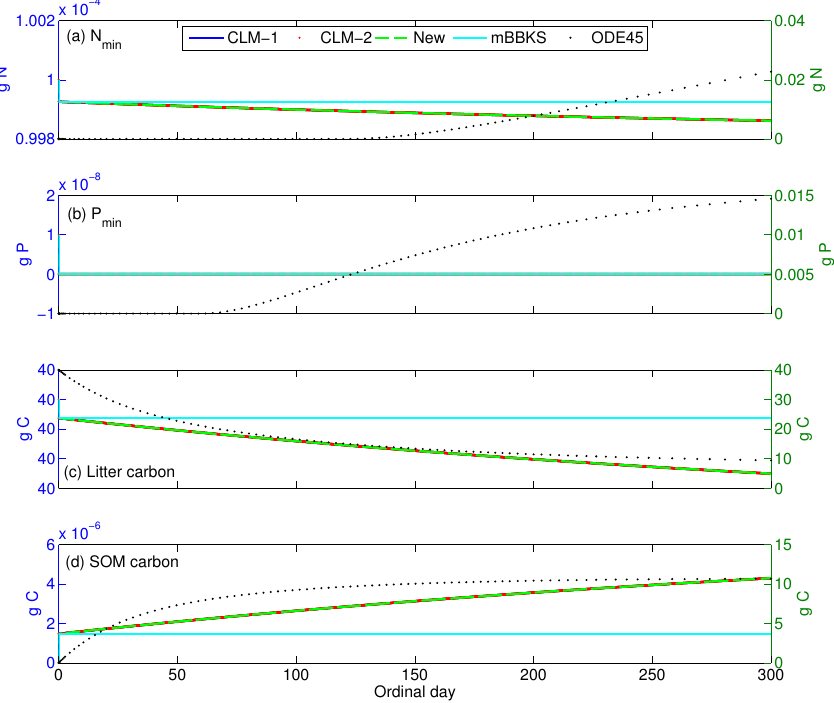
Figure 2. Simulated decomposition dynamics for Case 2 in Table 3. Note that the ODE45 scheme (shown on the right-hand y axes) predicted wrong results that are of much large magnitude than the other methods.